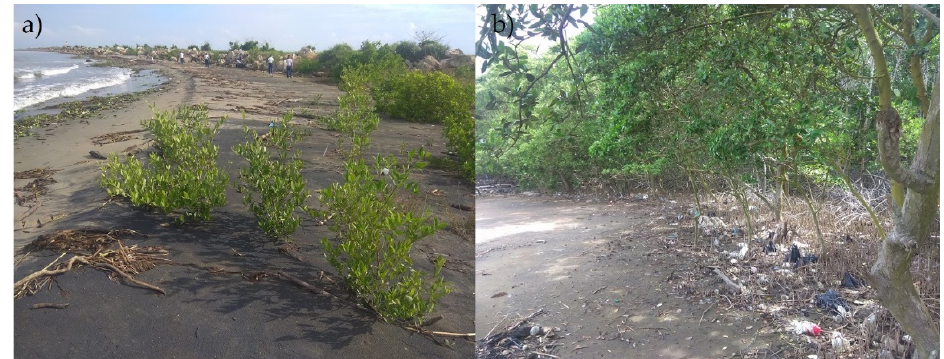
Figure 6. ( a ) Mangrove seedlings growing in the new sand bar, and ( b ) plastic waste observed in the mangrove forest of Mallorquín Swamp.